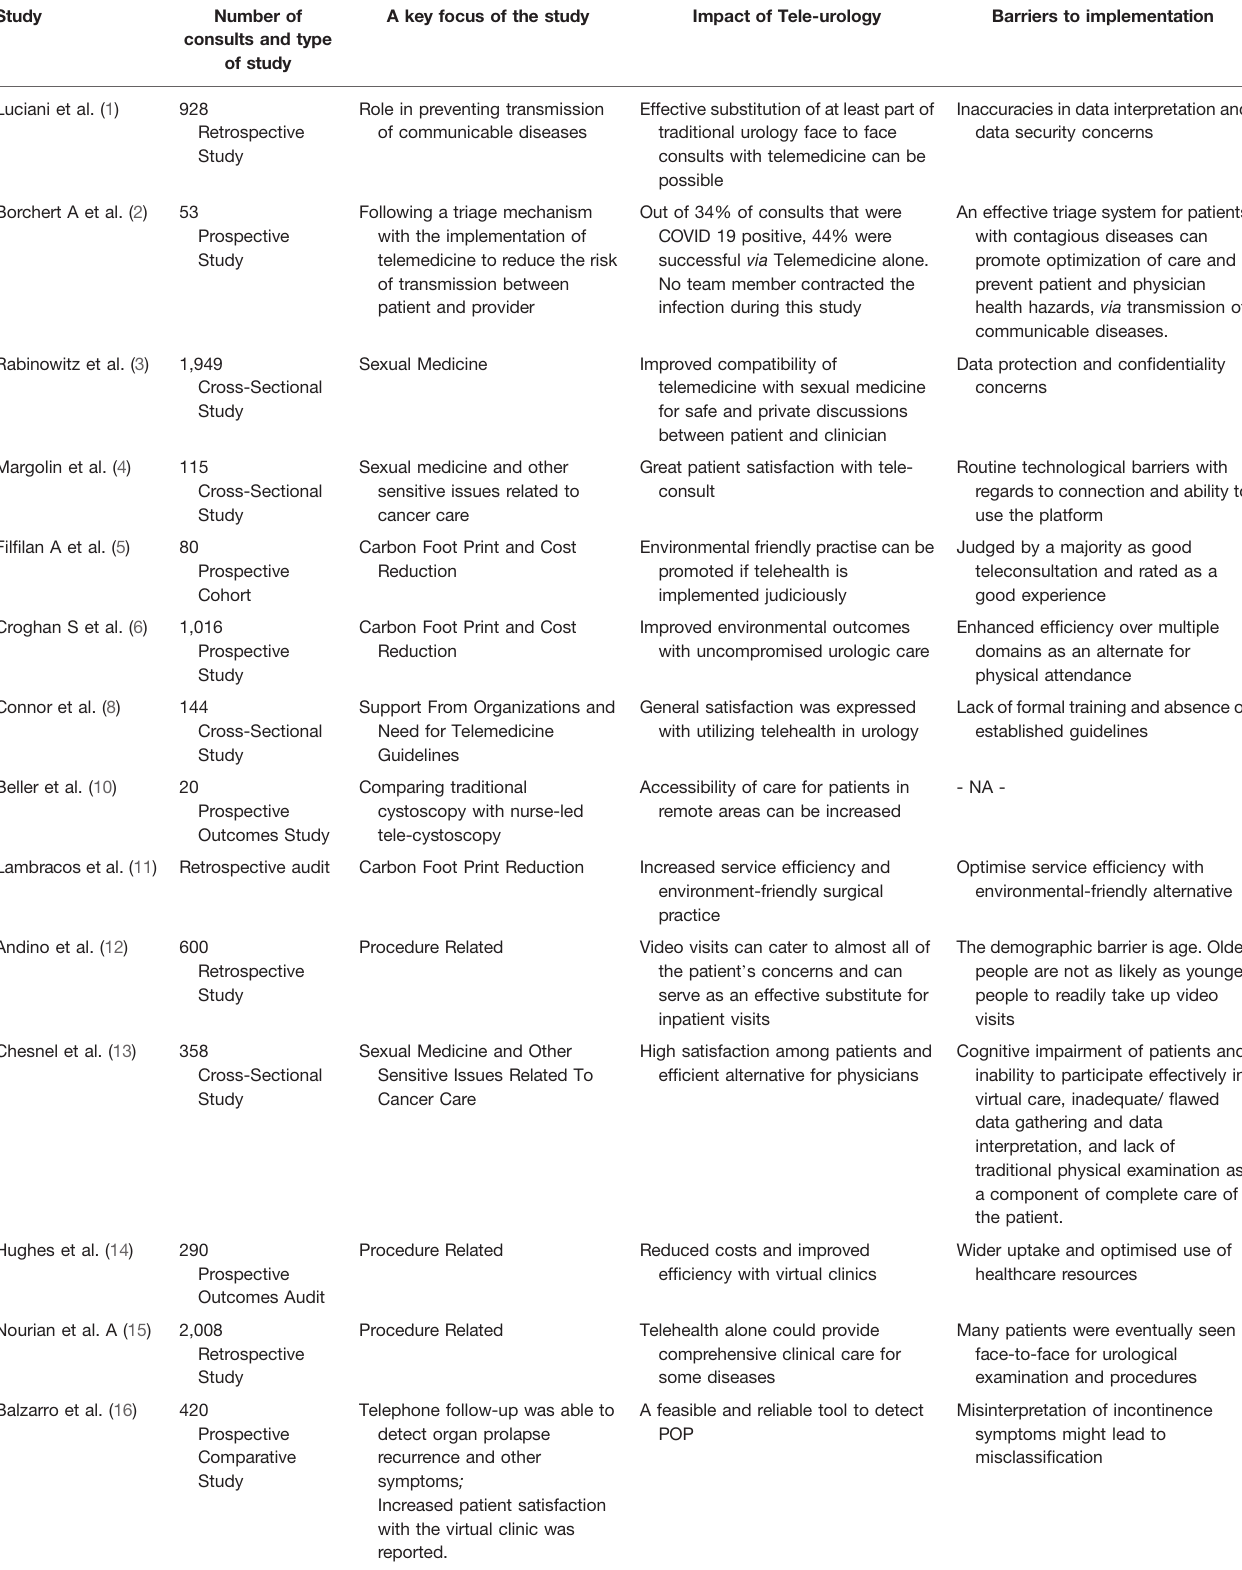
TABLE 1 | Summary of recent studies in urologists ’ perspectives on